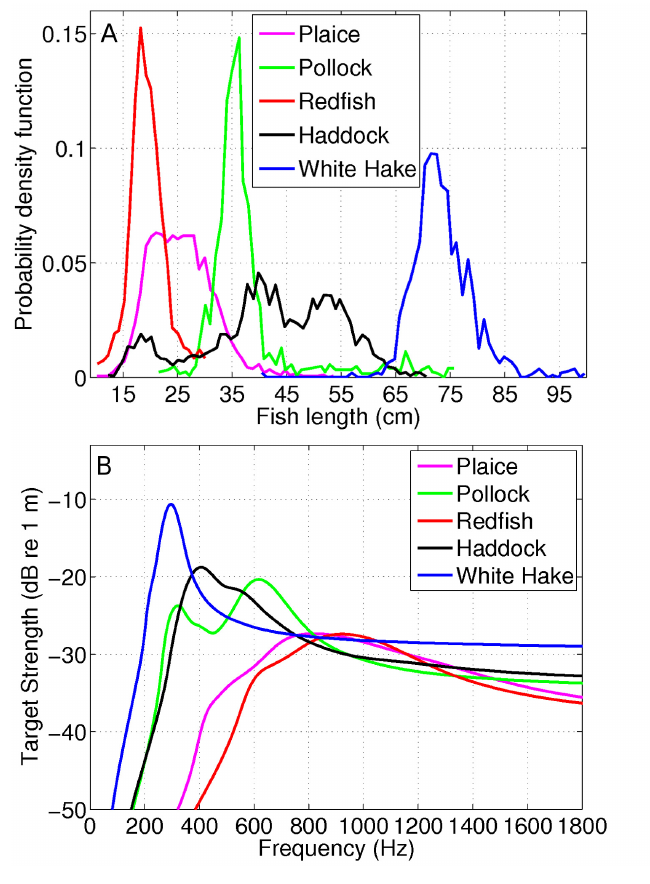
Figure 7. ( A ) The distribution of body lengths of some other groundfish species found along the coasts of Massachusetts and New Hampshire during spring 2005–2006 [69,71]. ( B ) The estimated target strength of these fish species following the body-length distribution in (A), located between 70 m and 80 m in the water column and neutrally buoyant at 70 m. All depths are measured from the sea-surface. The target strength of the different species is estimated using the Love model